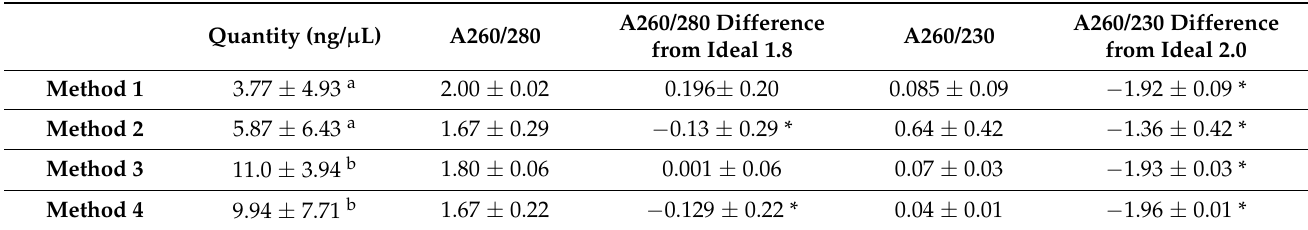
Table 1. The quality and quantity of DNA yield depends on the commercial DNA extraction method. Data are presented as median ± inter-quartile range. Lowercase letters indicate significant differences in DNA quantity between methods (post hoc Dunn test p < 0.05, n = 10/method). Asterisks indicate significance from the “ideal” ratio (Wilcox signed rank test p < 0.05, n = 10/method). No statistical analyses were performed on the A260/280 or A260/230 ratios.